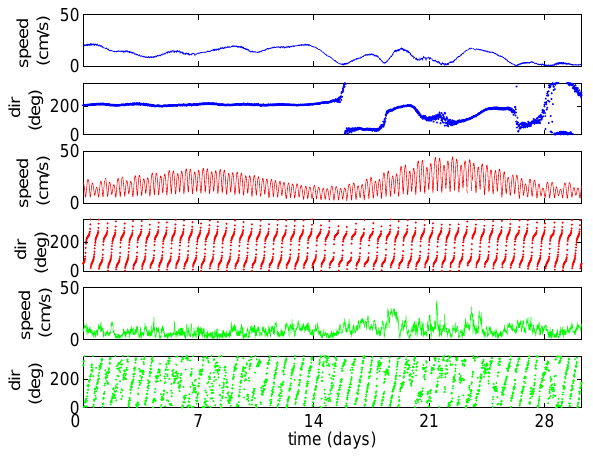
Fig. 12. From top to bottom speed (cms − 1 ) and direction (degrees) of mean-residual, tidal and surge components at location SB, 588m depth (from 14 October 1998 to 12 November